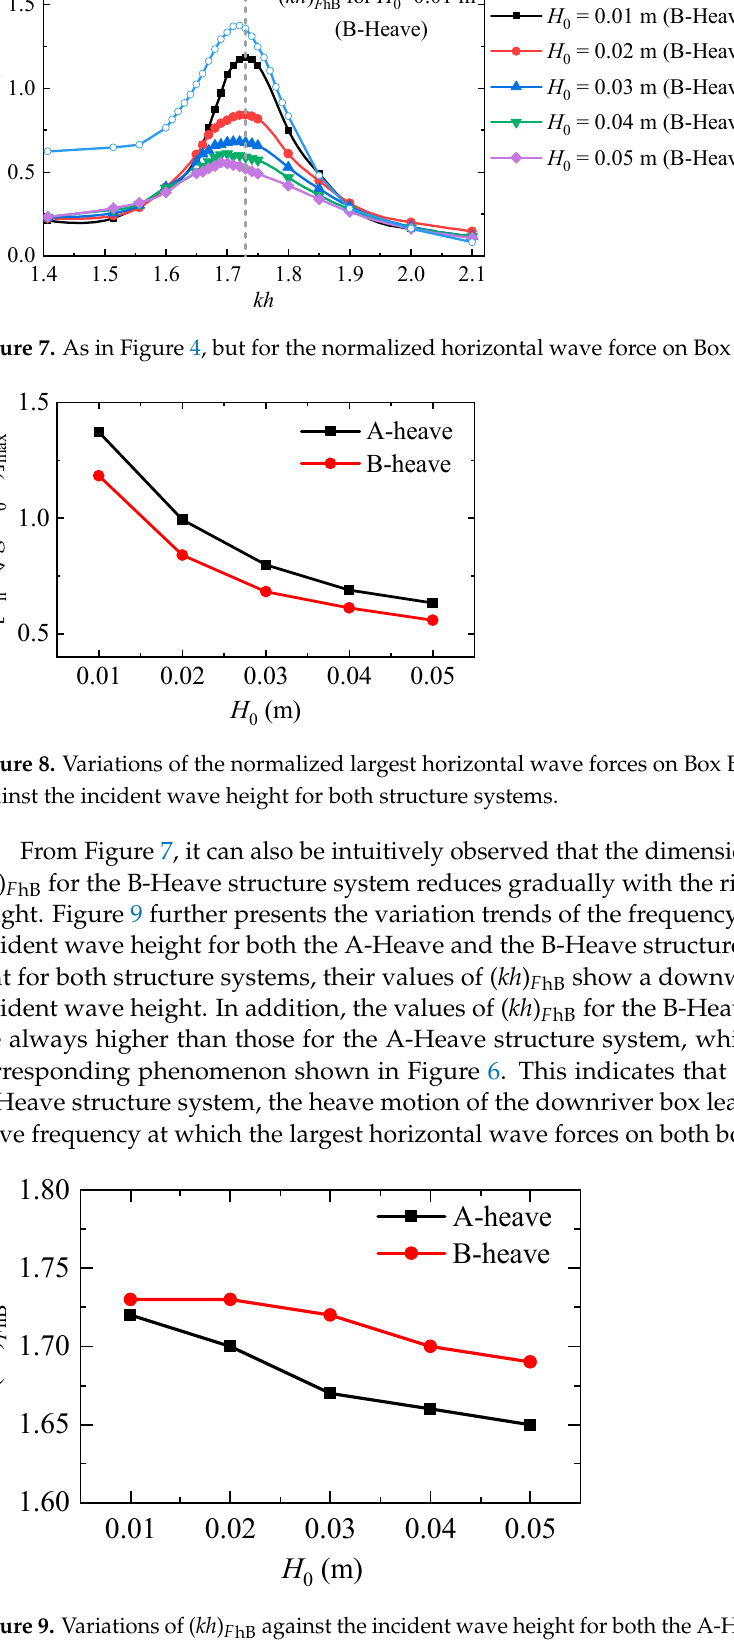
Figure 7. As in Figure 4, but for the normalized horizontal wave force on Box B.